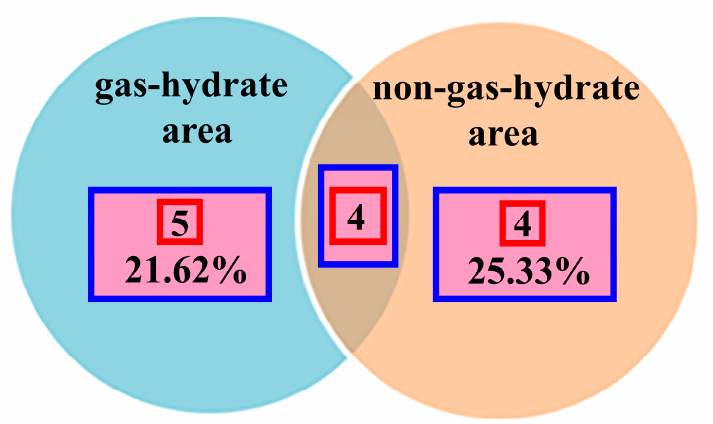
Figure 4. Comparison of the distribution of genera in the gas-hydrate and non-gas-hydrate regions. Red square—number of genera, blue square—number of unique genera for each zone as a percentage of the total number.